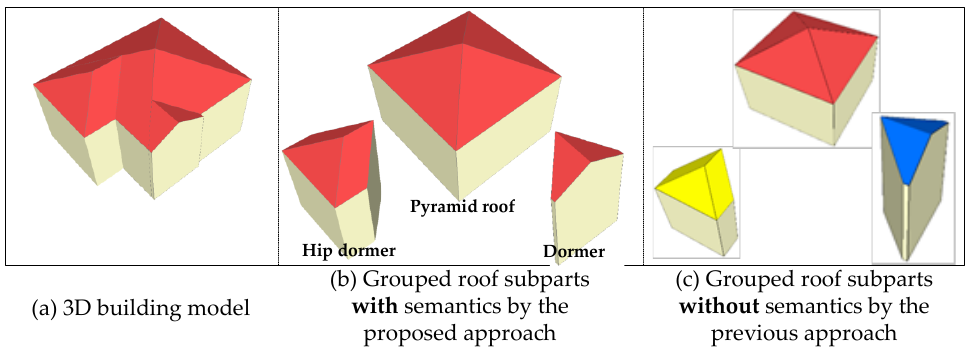
Figure 11. Comparison of experimental results (with vs. without semantic structures).